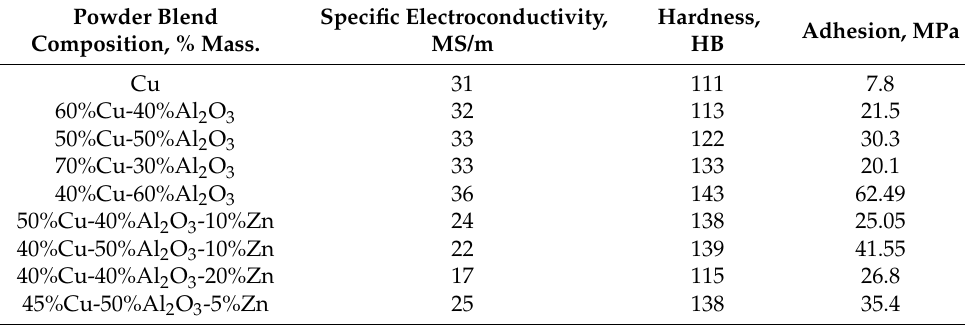
Table 3. The properties of cold sprayed coatings of different compositions.